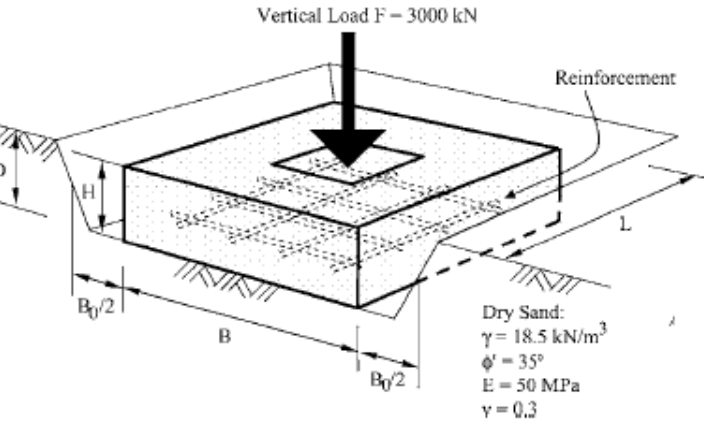
Figure 3. Spread footing design example.